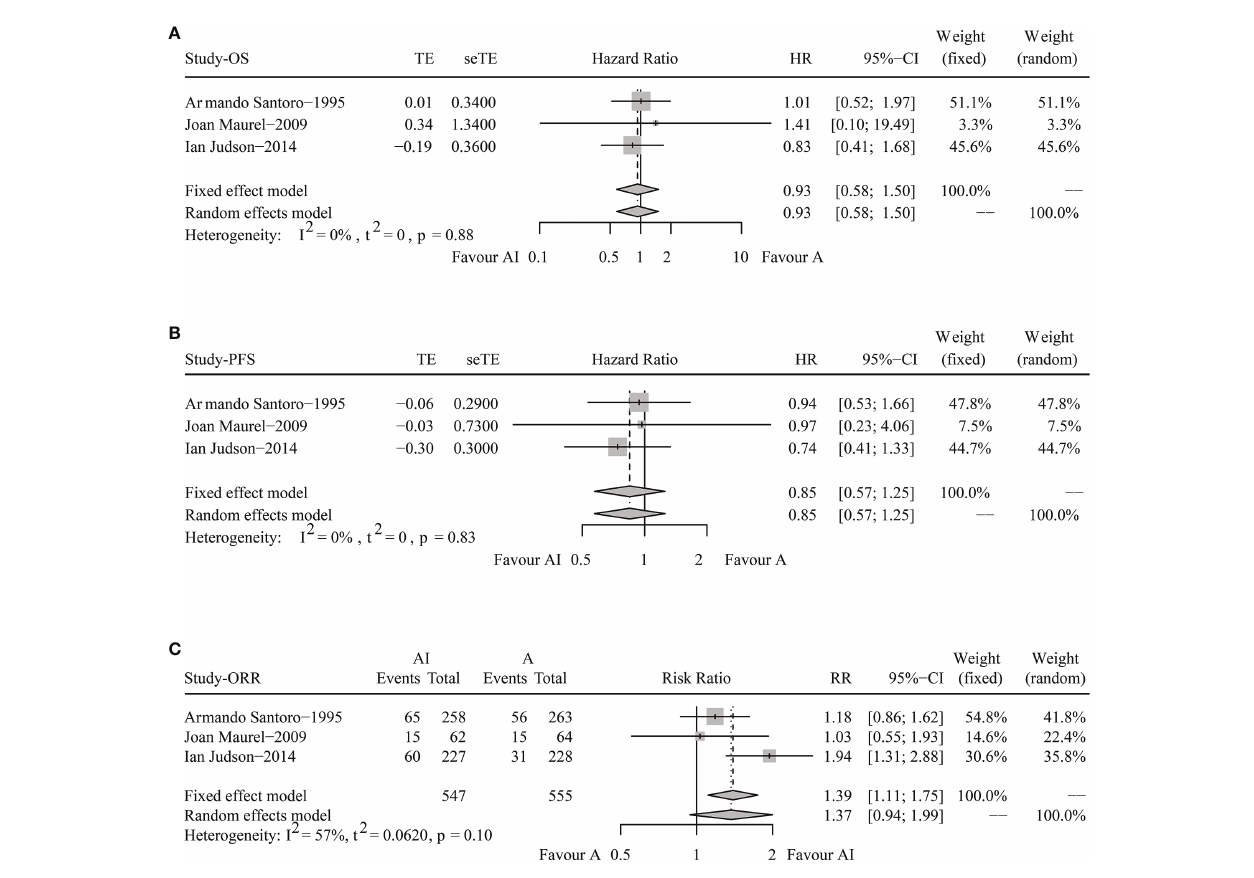
FIGURE 2 | Forest plots of the pooled hazard ratio for overall survival (A) and progression-free survival (B) and odds ratio for objective response rate (C) between doxorubicin/adriamycin plus ifosfamide combination chemotherapy and doxorubicin/adriamycin